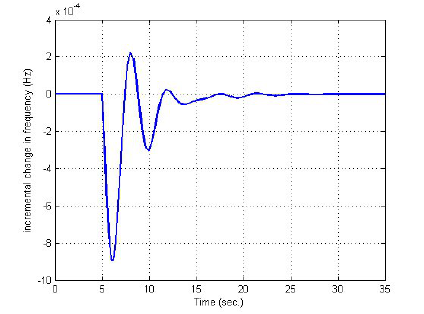
Fig. 3: Frequency deviation of area-1 (Case 1)